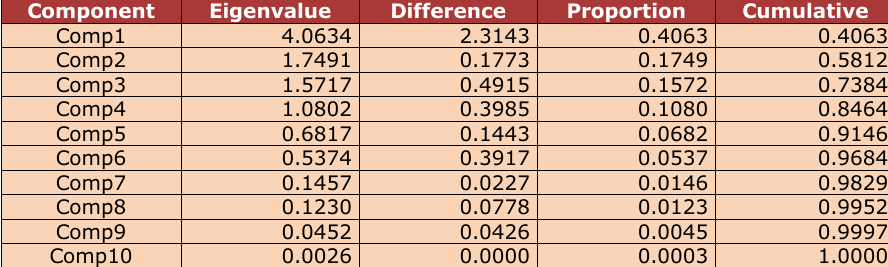
Table 2. Table of Principal Component Eigenvalues and Contribution